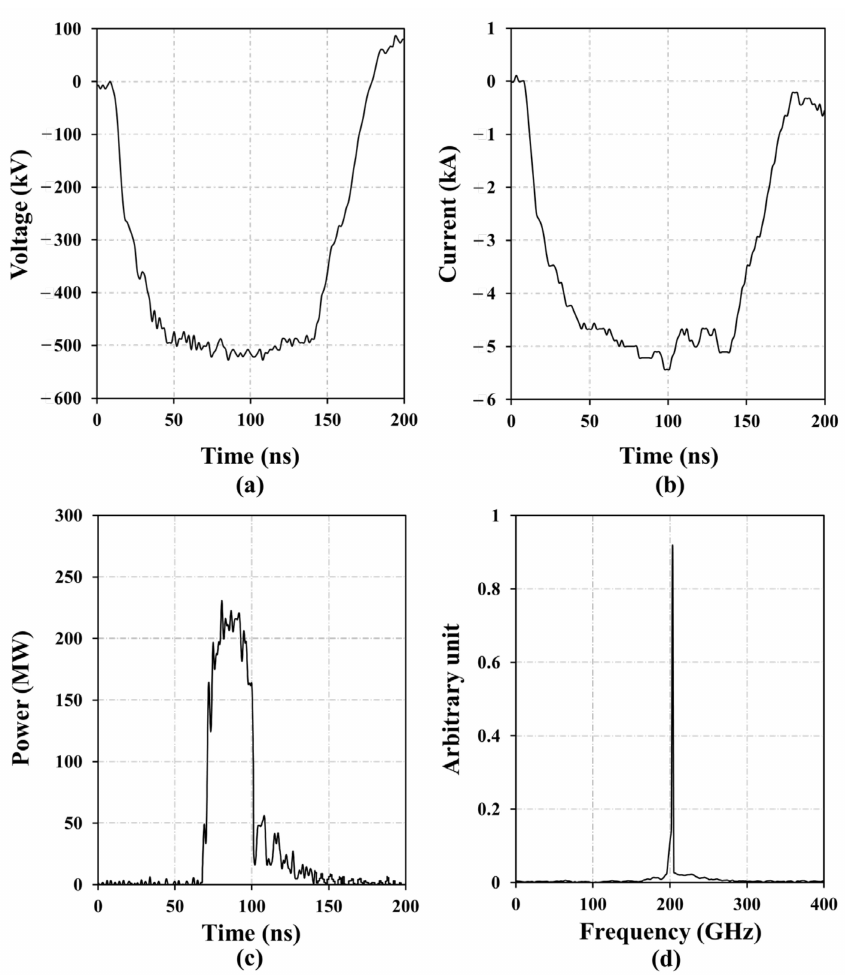
Figure 8. Measured parameters in the plasma wakefield accelerator: ( a ) beam voltage, ( b ) beam current, ( c ) output power, ( d ) operating frequency (fast Fourier transform, FFT).